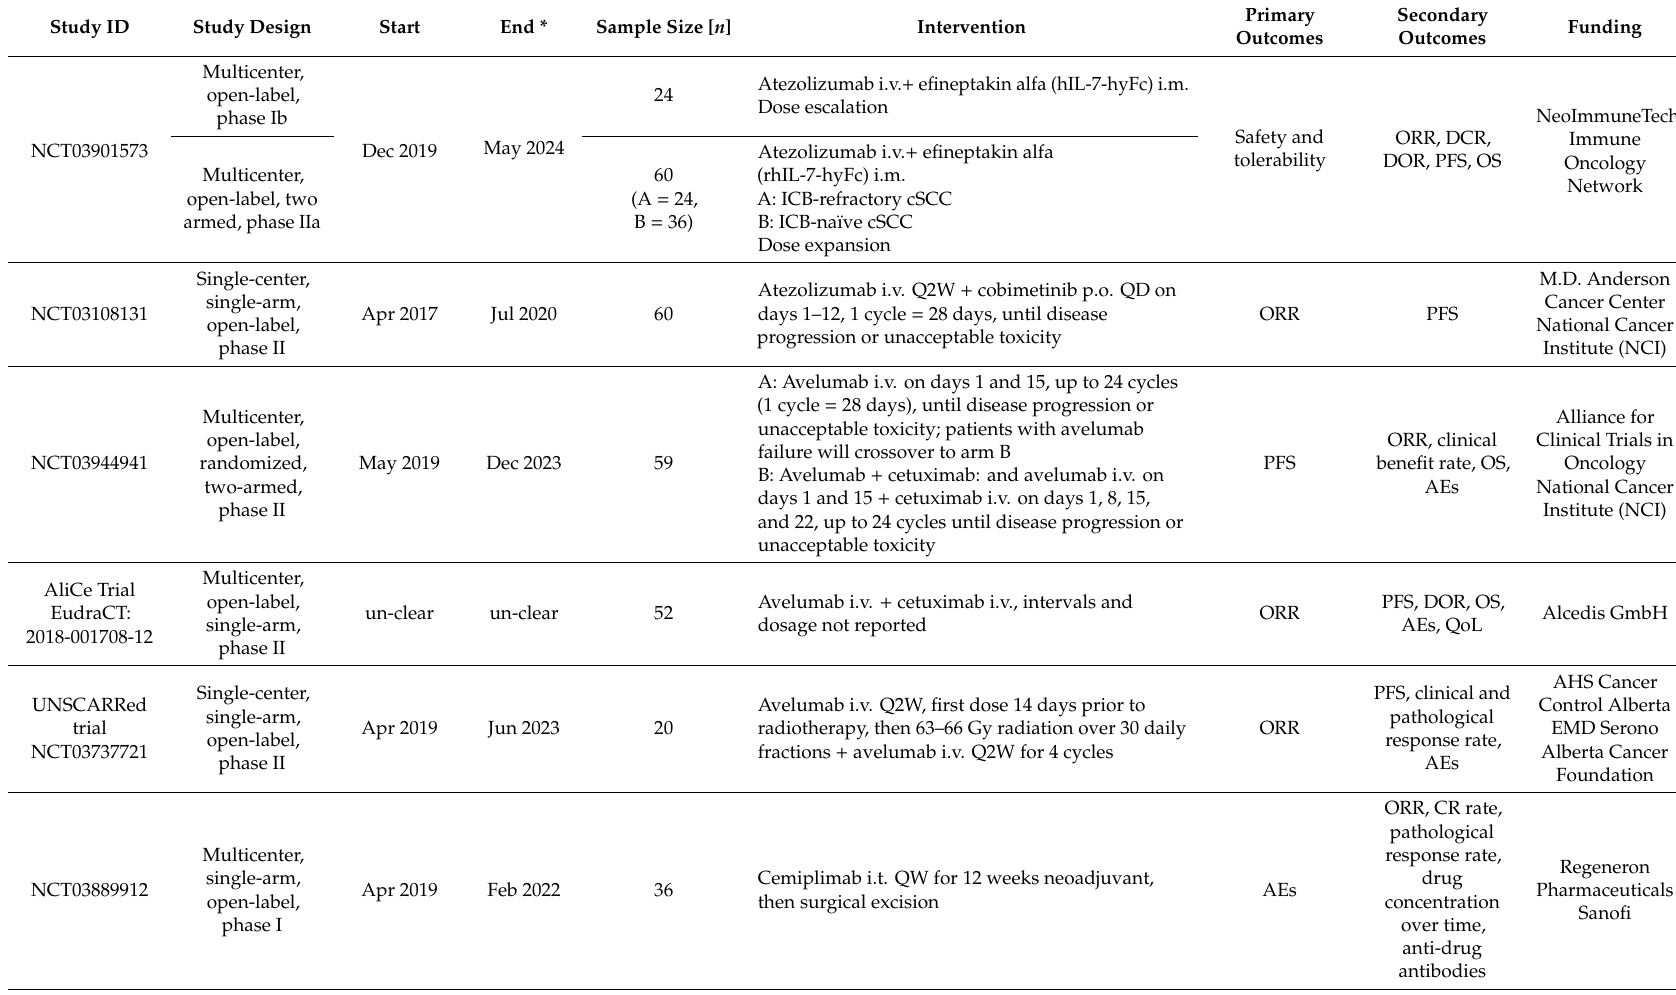
Table 2. Ongoing trials investigating immune checkpoint blockade (ICB) in advanced